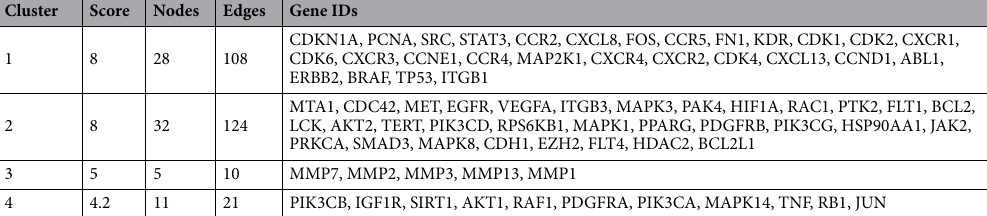
Table 2. Clusters of the protein–protein interaction (PPI) network.